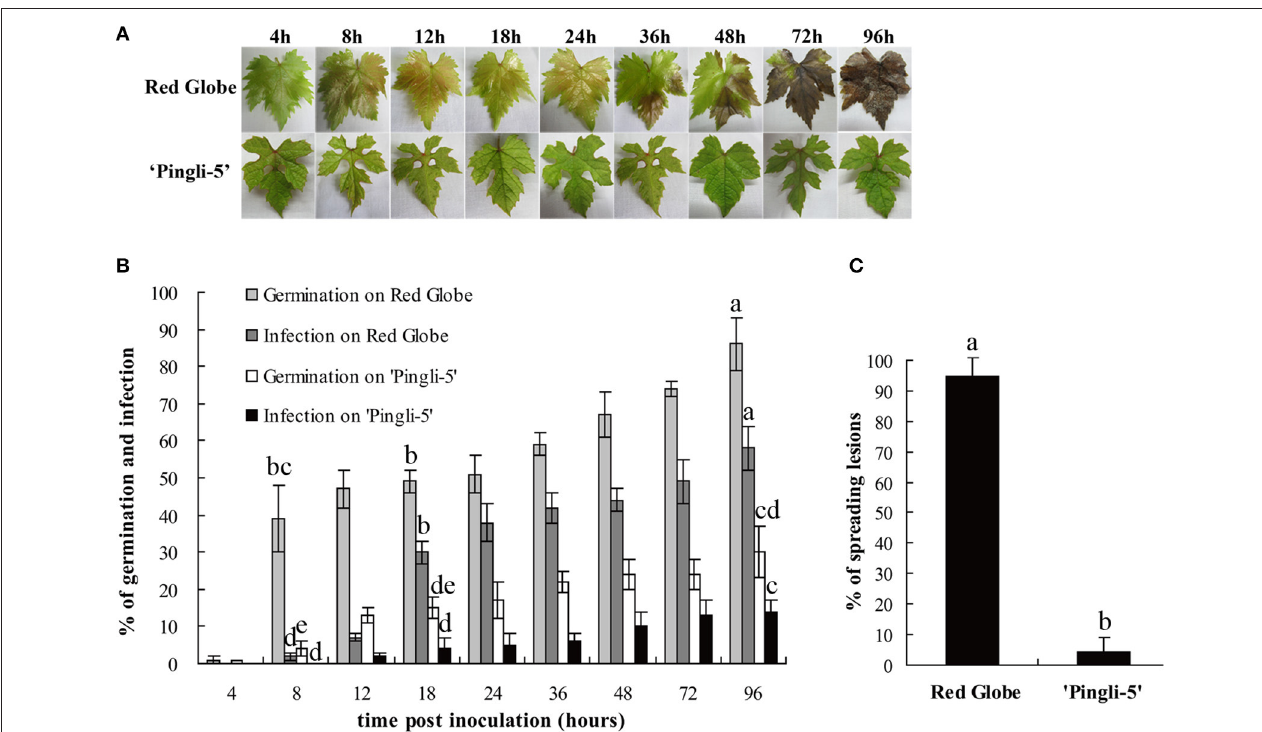
FIGURE 3 | Disease development after inoculation of leaves from the highly susceptible V. Vinifera “Red Globe” and the highly resistant Chinese wild Vitis “Pingli-5.”(A) Picturesweretaken4,8,12,18,24,36,48,72,and96hpost-inoculation(hpi).Lesionswererarelyobservedon“Pingli-5,”whilenecrosisdeveloped rapidly on “Red Globe” from 24 hpi onwards. One representative leaf of three replicates is shown for each time point. (B) Statistical analysis of conidia germination and infection rates. Lower rates of germination and invasion of B. cinerea were shown on “Pingli-5” than on “Red Globe.” At least 300 conidia were counted at each indicated time point. (C) Percentage of spreading lesions on “Red Globe” and “Pingli-5” leaves 4 days post-inoculation. Data represent the means of three experiments. Error bars denote standard deviations. Comparisons of statistical significance were made for the three indices. Different small alphabetical letters indicate statistically significant differences between different interactions of “Red Globe” and “Pingli-5” with B. cinerea at the indicated time points (Duncan’s multiple range test; P < 0.05